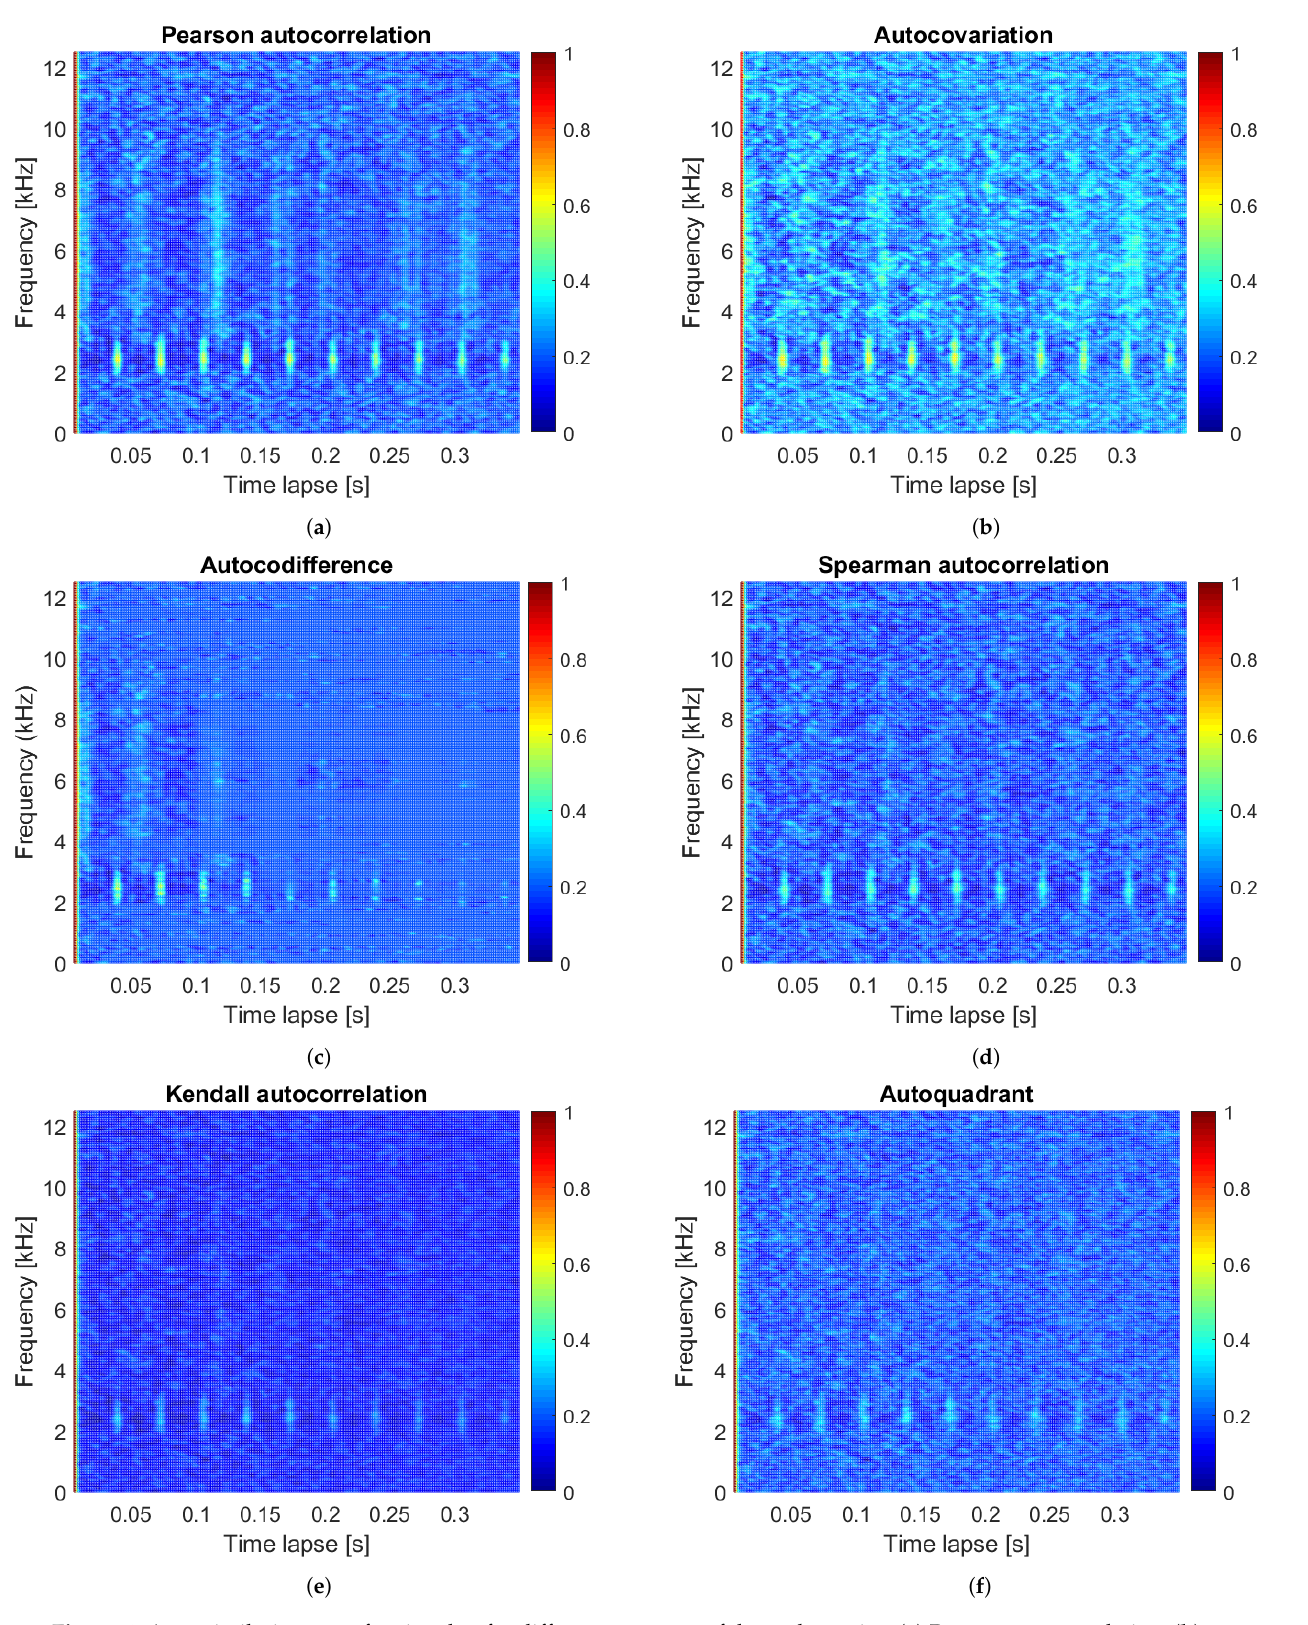
Figure 4. Auto-similarity maps for signal s 1 for different measures of dependence, i.e., ( a ) Pearson autocorrelation, ( b ) auto- covariation, ( c ) autocodifference, ( d ) Spearman autocorrelation, ( e ) Kendall autocorrelation, ( f ) Quadrant